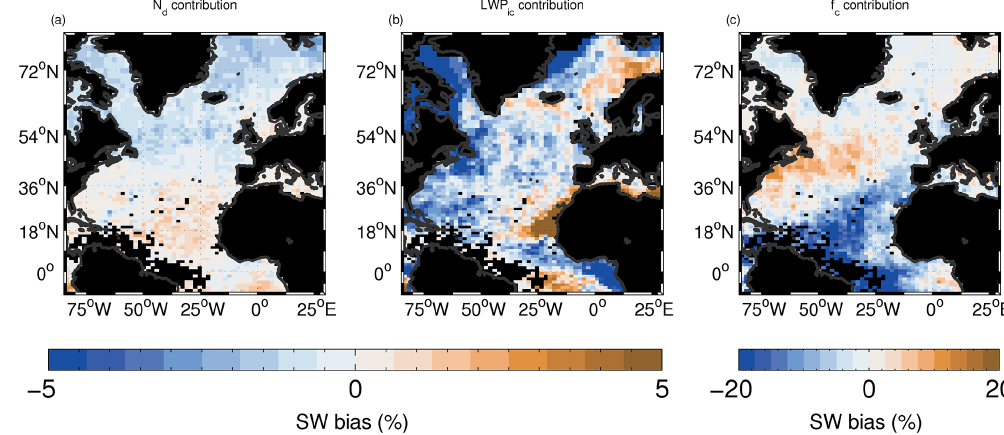
Figure 10. Estimated contributions from the model biases in N d ( a ; note the smaller colour bar range), LWP ic (b) and f c (c) to the SW TOA model bias (Fig. 8c). Values are expressed as a percentage of the observed CERES SW TOA field for consistency with Fig. 8c. Figure 9c shows the sum of these three contributions also as a percentage of the observed CERES SW TOA .